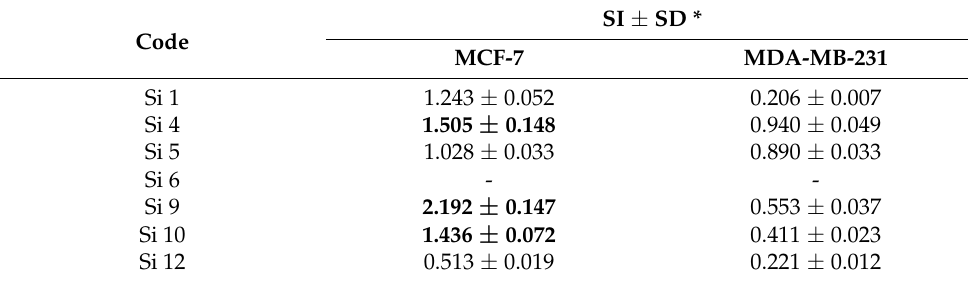
Table 3. Selective index calculated by IC 50 values of MCF-10A cell